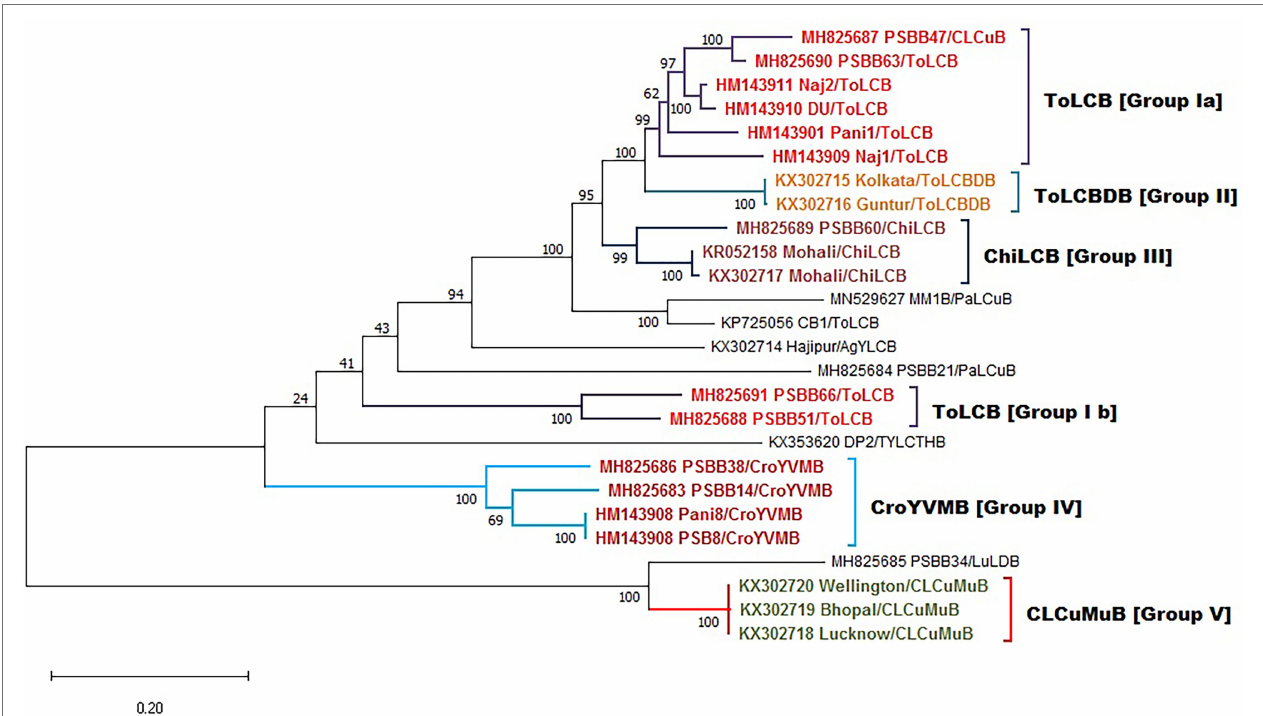
FIGURE 8 | Maximum-likelihood phylogeny-based partitioning tree of begomoviruses linked betasatellites associated with PaLCD in India aligned using CLUSTAL W with 1,000 bootstrap value in the MEGA v.10 program; 26 betasatellites isolates for five distinct groups.